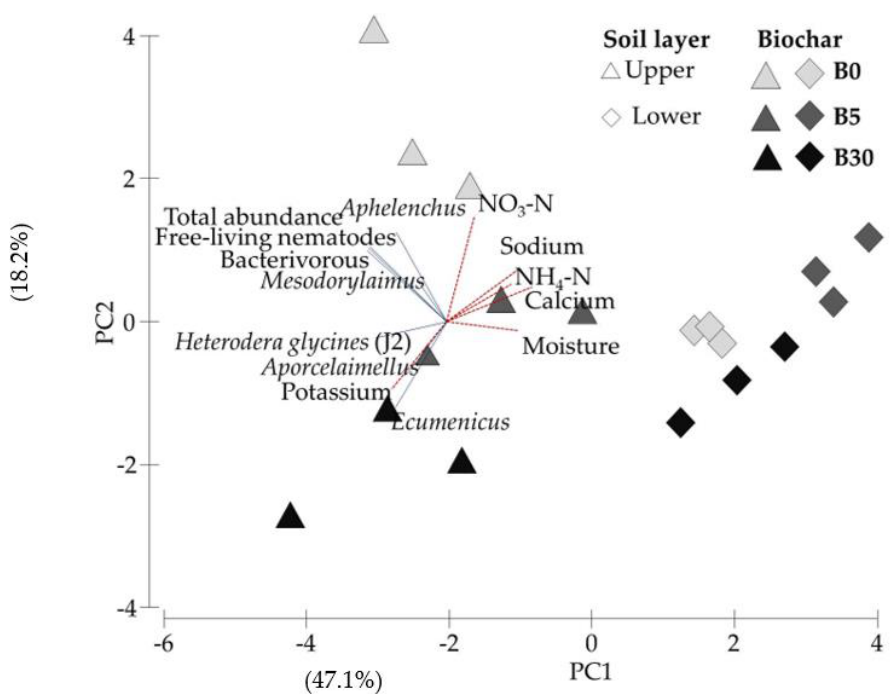
Figure 5. Ordination of first (PC1) and second (PC2) principal components derived from analysis of whole soil properties (combined data of upper and lower layer soils) subject to biochar amendment in the upper layer at 0 (B0), 0.3% (B5) and 1.8% (B30). Percent variations accounted for by PC are given in parentheses on axis labels.